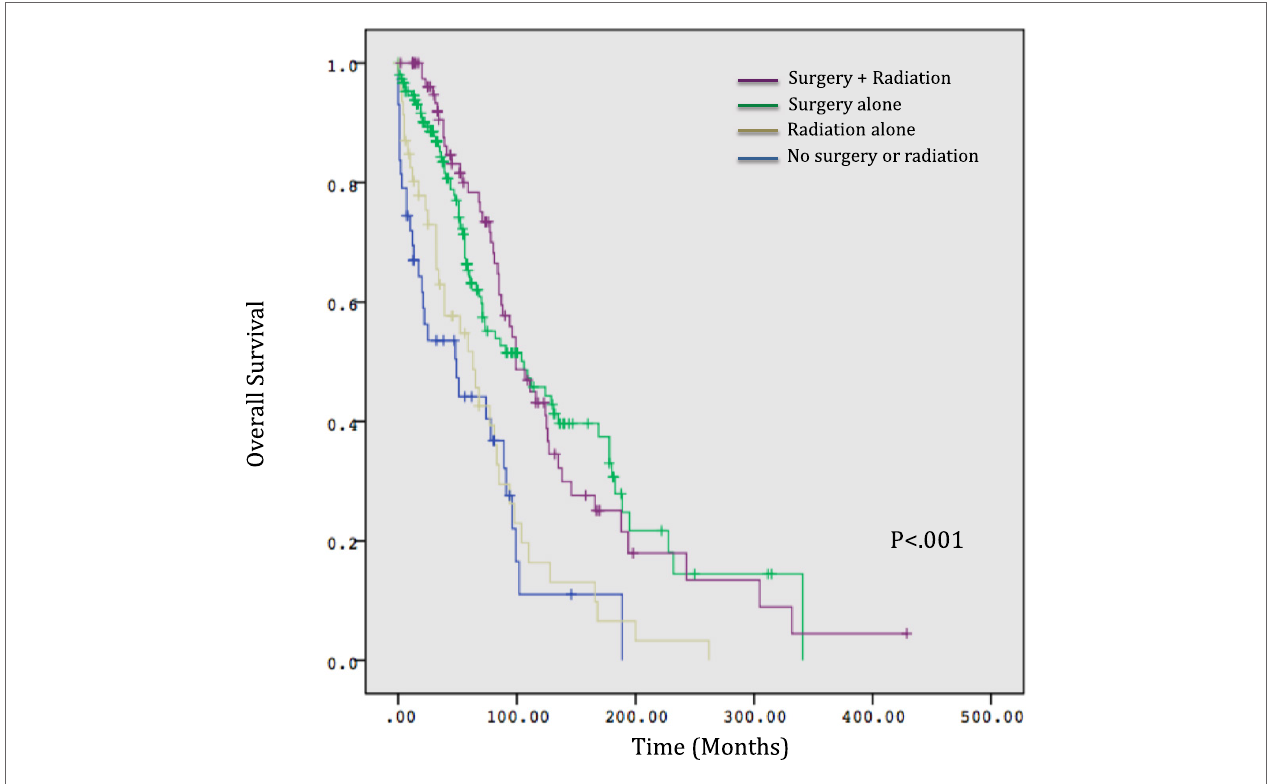
FigUre 2 | Overall survival by treatment modality